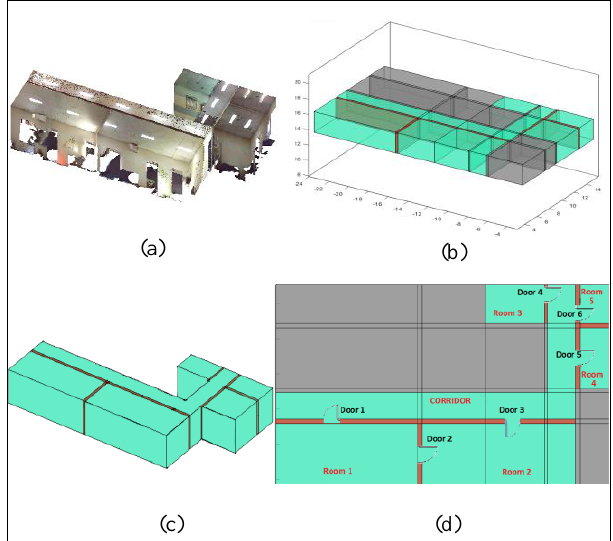
Figure 8. The geometric and semantic reconstruction of the real point cloud of the office building. (a) the input point cloud; (b) the result of cuboid placement, classification, and merging; (c) the final 3D indoor model; (d) the top-view of the 3D model with space labels and the grid of cuboids. The doors are added